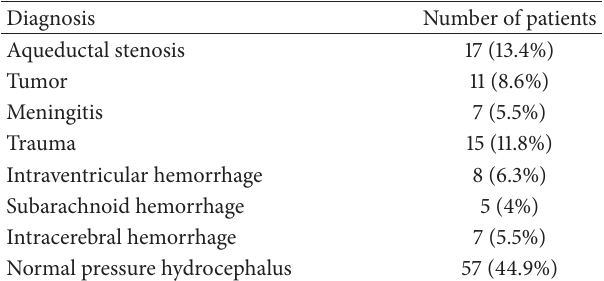
Table 1: Initial diagnosis that prompted shunt